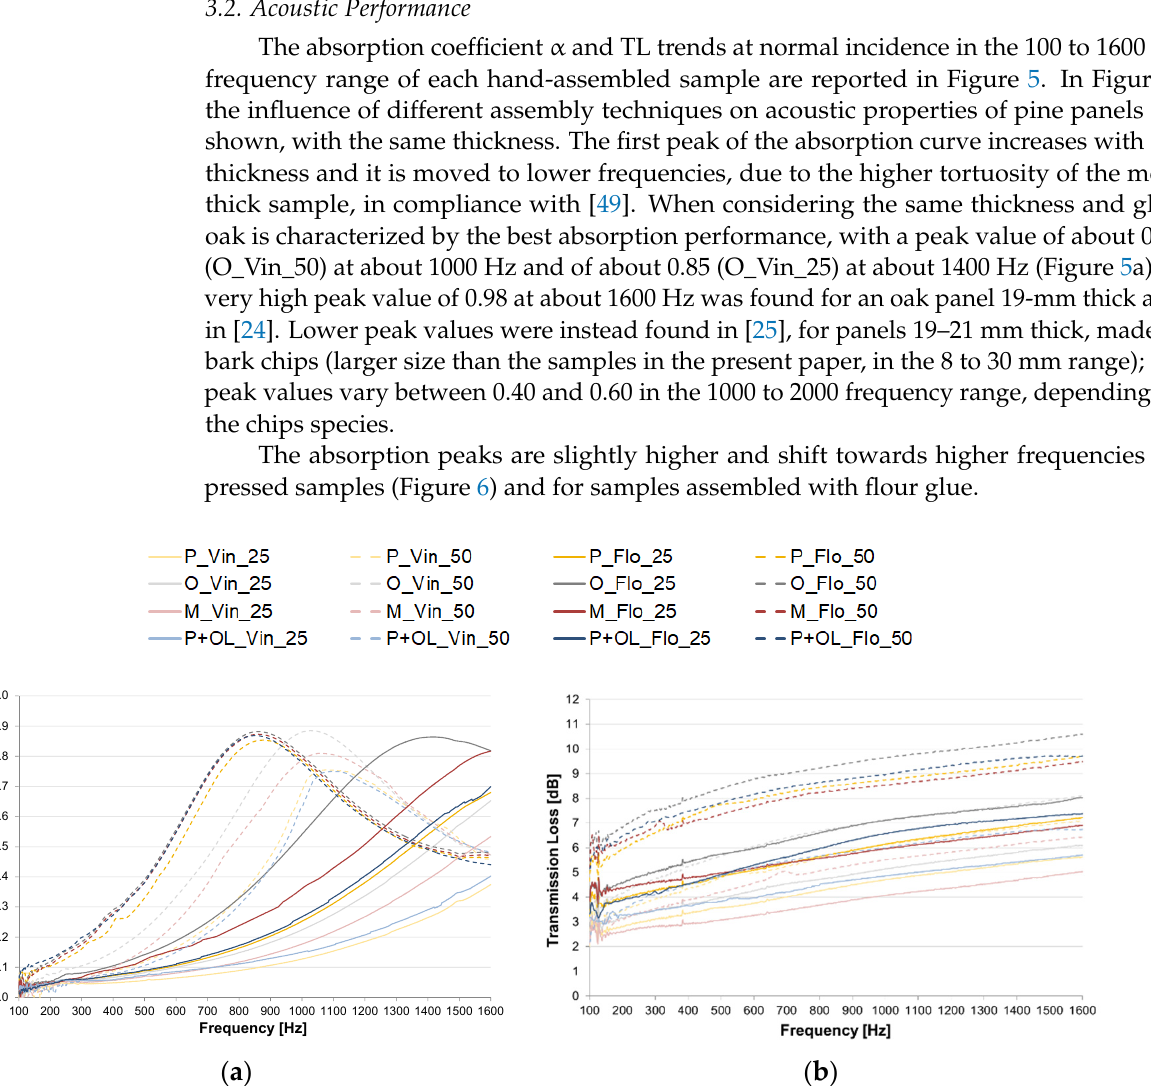
( b ) Figure 6. Influence of pressing technique on the acoustic performance of pine panels: ( a ) sound absorption coefficient and ( b ) Transmission loss at normal incidence. The oak samples (more dense) have the best transmission loss performance (Figures 5b and 6b). In general, the flour glue improves TL-values: the increase is limited in the 25- mm samples (about 1.5 dB), whereas it is about 2–3 dB in the 50-mm thick panels. The sound insulation properties of pine and mahogany with natural glue are similar (TL = 2.5– 5.5 dB and TL = 4–7 dB for the 25-mm and 50-mm thick samples, respectively). Oak TL values are about 1.5–2.5 dB (25-mm) and 2–4 dB (50-mm) higher than pine and mahogany. Adding olive trees to the mixture results in a maximum increase of 0.5 dB in the 25-mm flour glue sample. On the contrary, pressing involves an increase in density and consequently in acoustic insulation performance; TL increases up to 2.5 dB in the panel